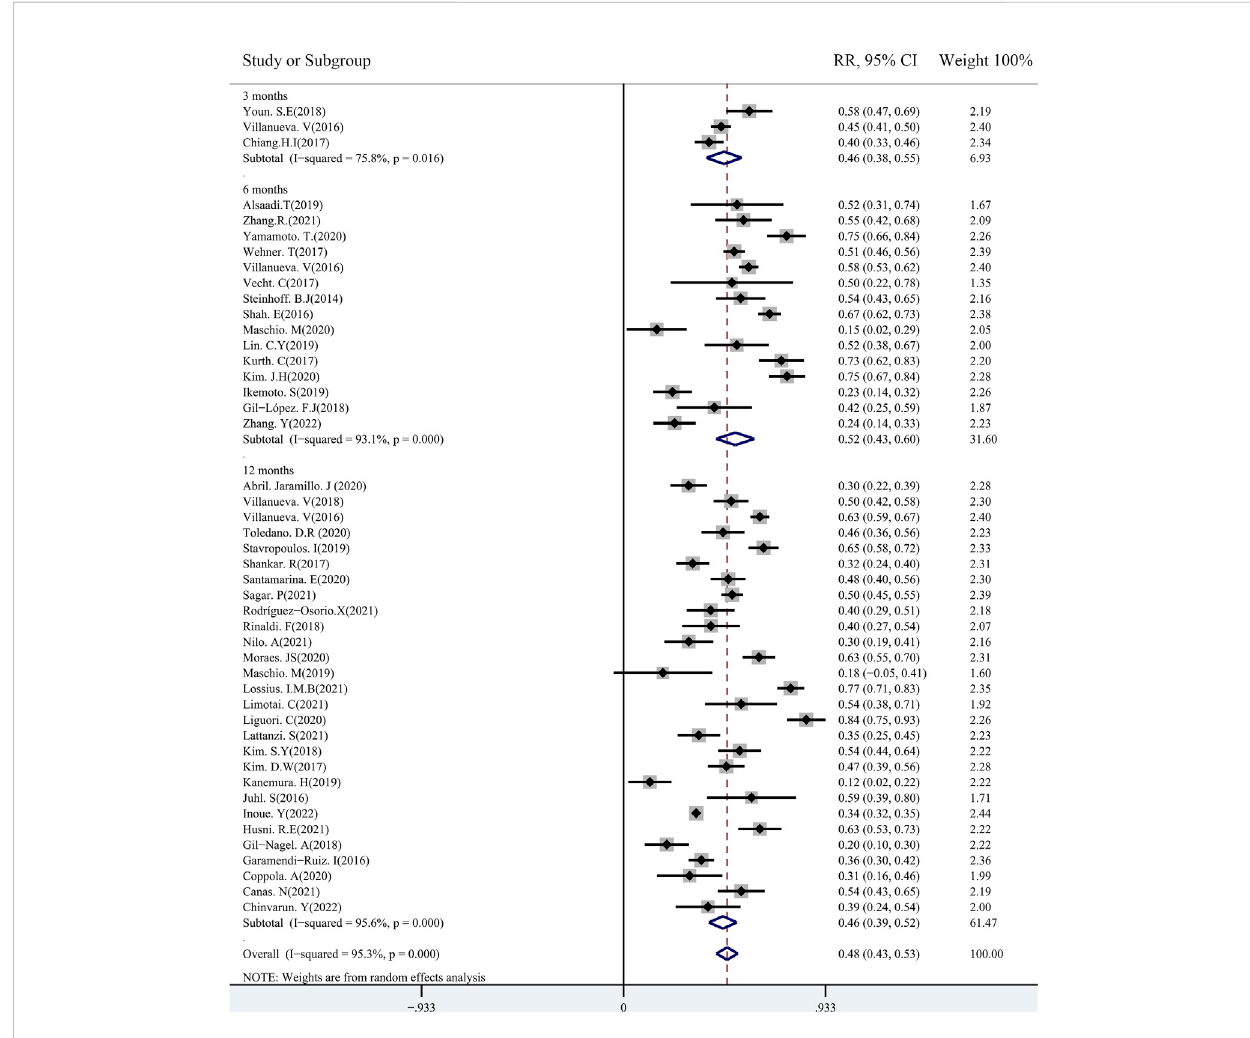
FIGURE 9 Meta-analysis of adverse events rate: pooled data from 44